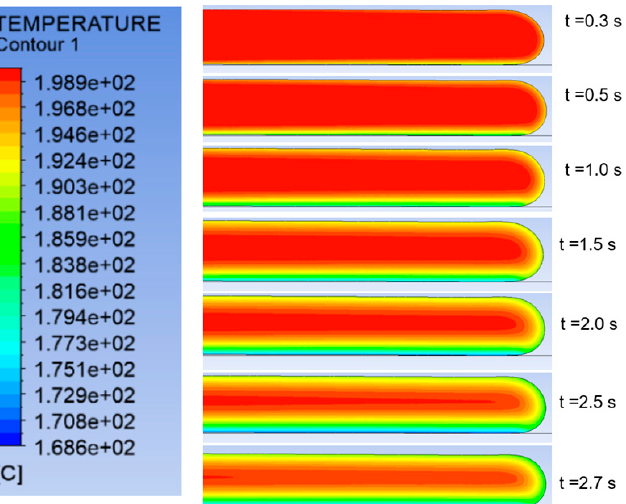
Figure 8. Snapshots of temperature contours during material deposition in large-scale AM. To ac- count for the increase in material volume during extrusion, an adaptive remeshing scheme refines elements that have deformed significantly and become too stretched on the melt free surface.